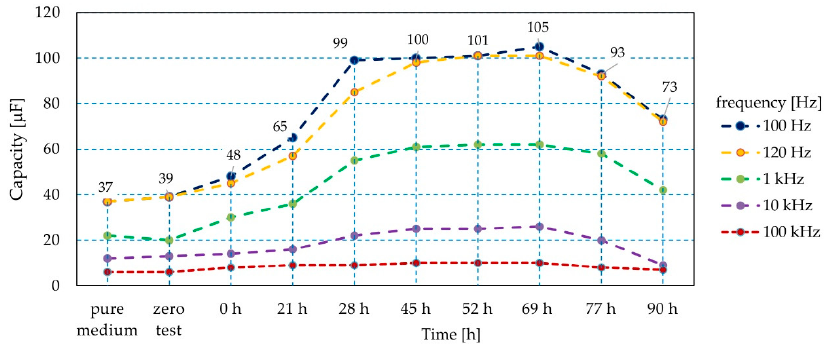
Figure 10. Characteristics of the textile sensor capacitance during bacterial colony development.